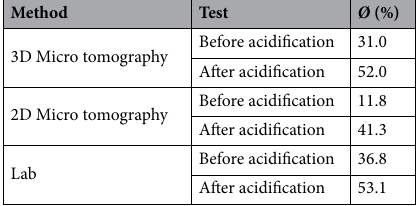
Table 3. Comparison of porosity